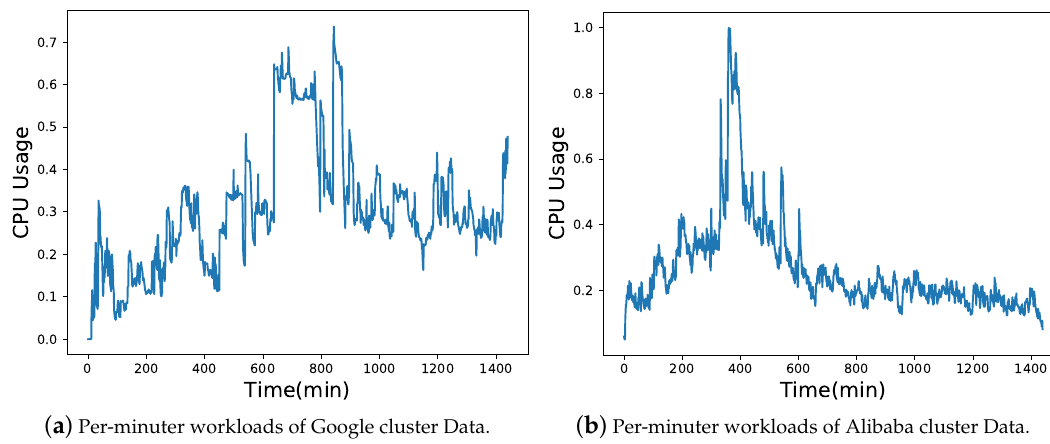
( b ) Per-minuter workloads of Alibaba cluster Data. Figure 3. The highly random workloads in data centers.